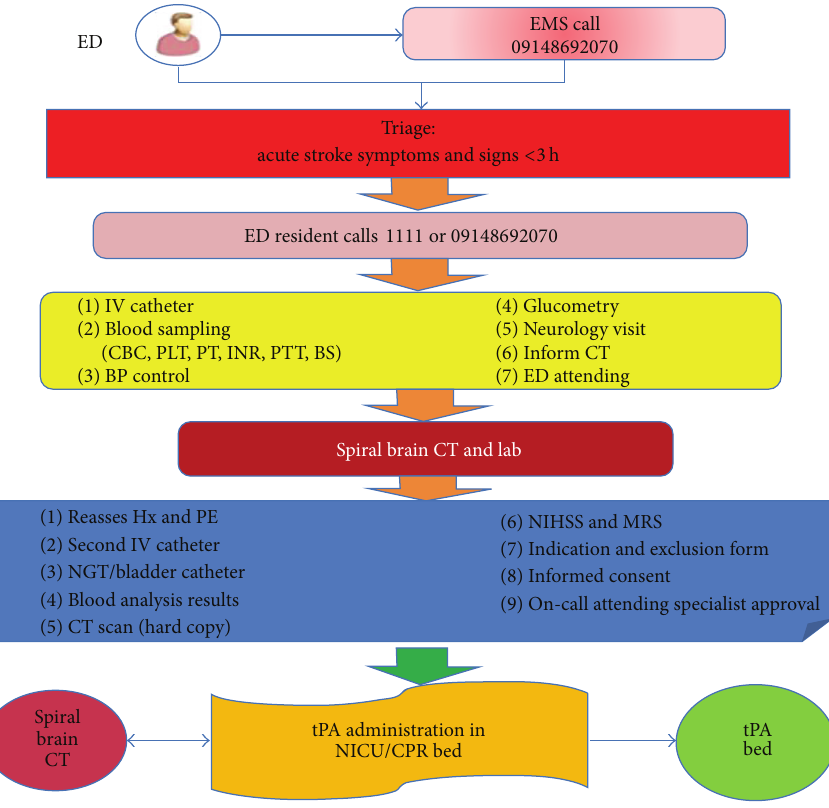
Figure 1: Management of acute ischemic stroke patients for tPA therapy in Tabriz Imam Reza